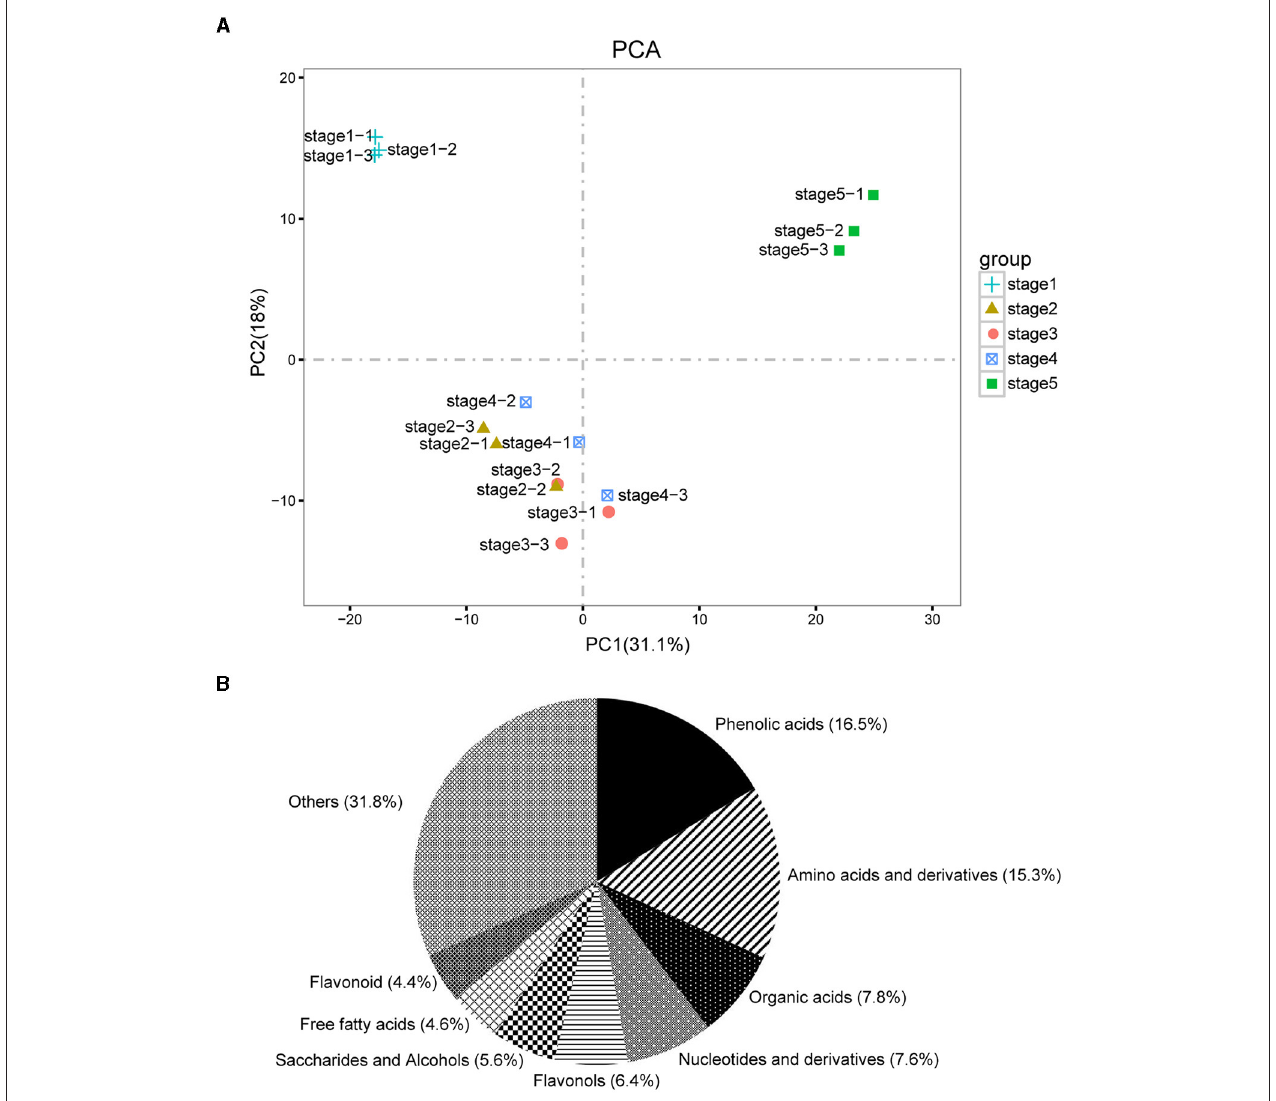
FIGURE 2 | Overall qualitative and quantitative analyses of the metabolomics data. (A) Principal component analysis (PCA) of the five development stage samples and quality control samples (mixed); the x-axis represents the first principal component, and the y-axis represents the second principal component. (B) Component analysis of the identified metabolites. The top eight metabolites are shown beside the